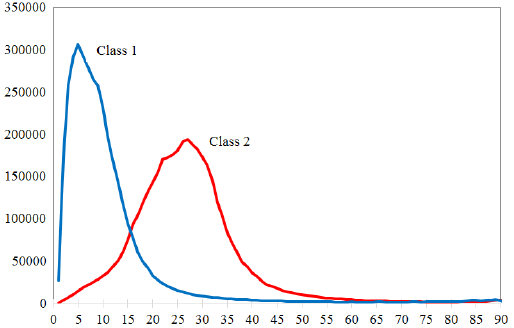
Figure 6. Histogram of two classes of the gradient